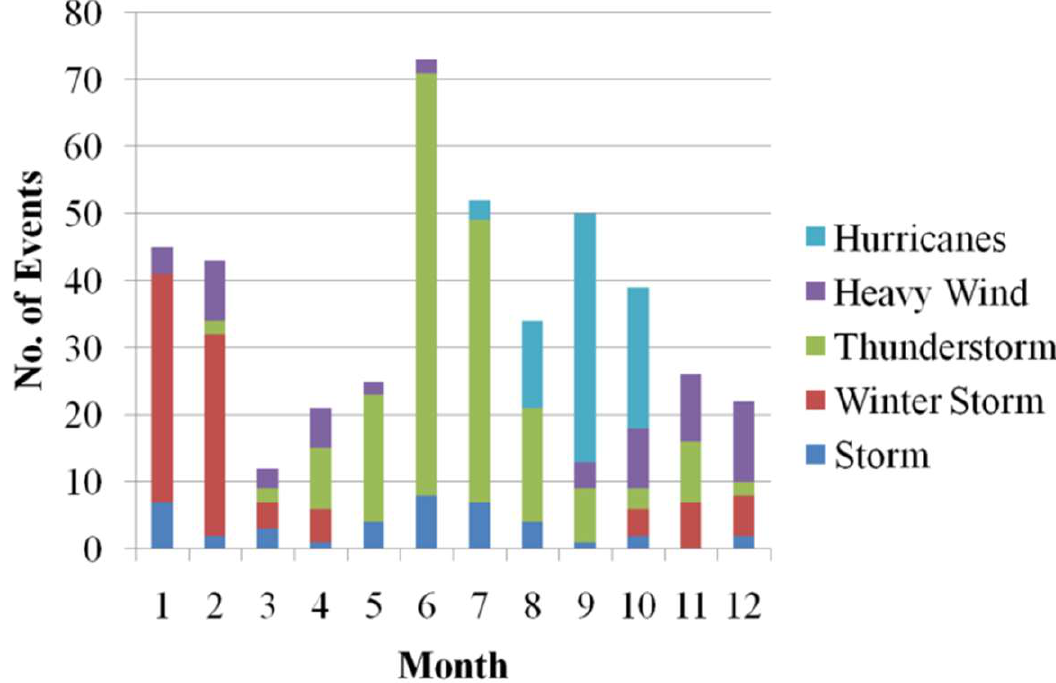
Figure 4. Month-wise occurrence of top five weather-related natural disasters [35].